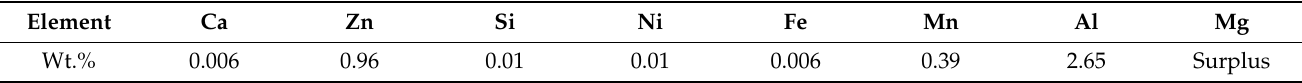
Table 1. Chemical composition of AZ31B alloy.